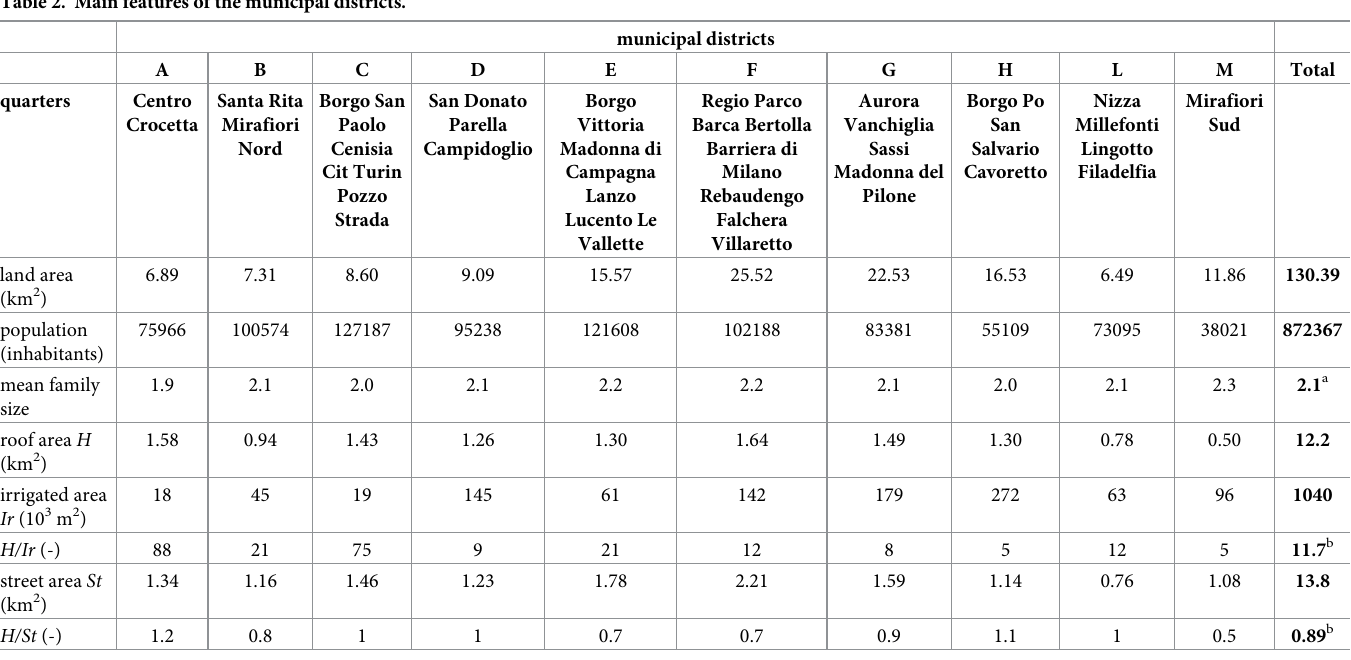
Table 2. Main features of the municipal